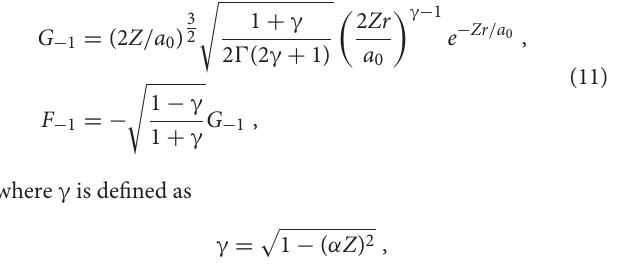
FIGURE 2 | The large component, G − 1 , of the bound-muon wave function in 106 Cd. Here “B-S” refers to the Bethe-Salpeter approximation formula and “Dirac” to the wave function obtained by solving the Dirac equation. Furthermore, “pl” refers to a point-like nucleus and “fs” to a finite-size